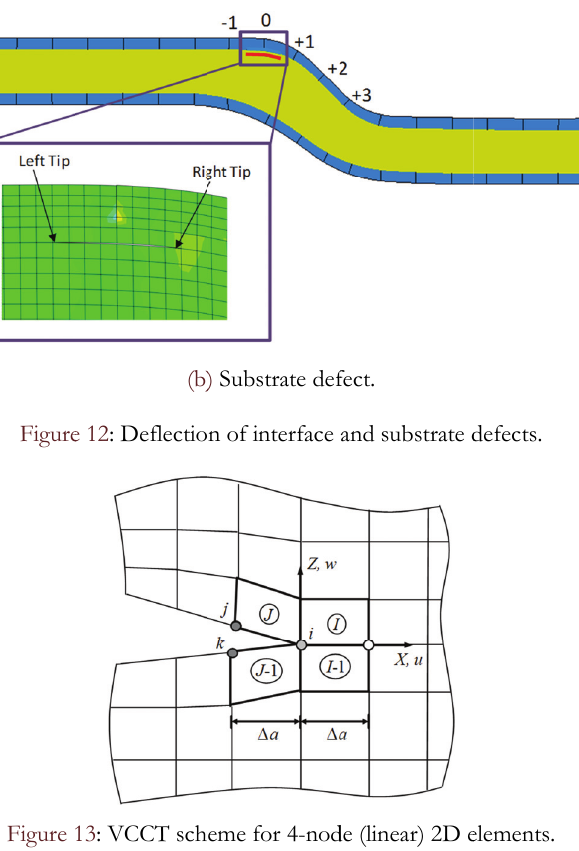
conservative c G Ic , which